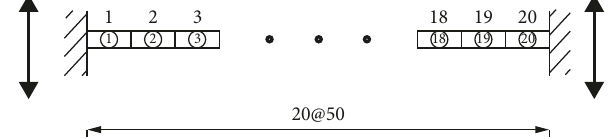
Figure 8: A fixed-ended beam